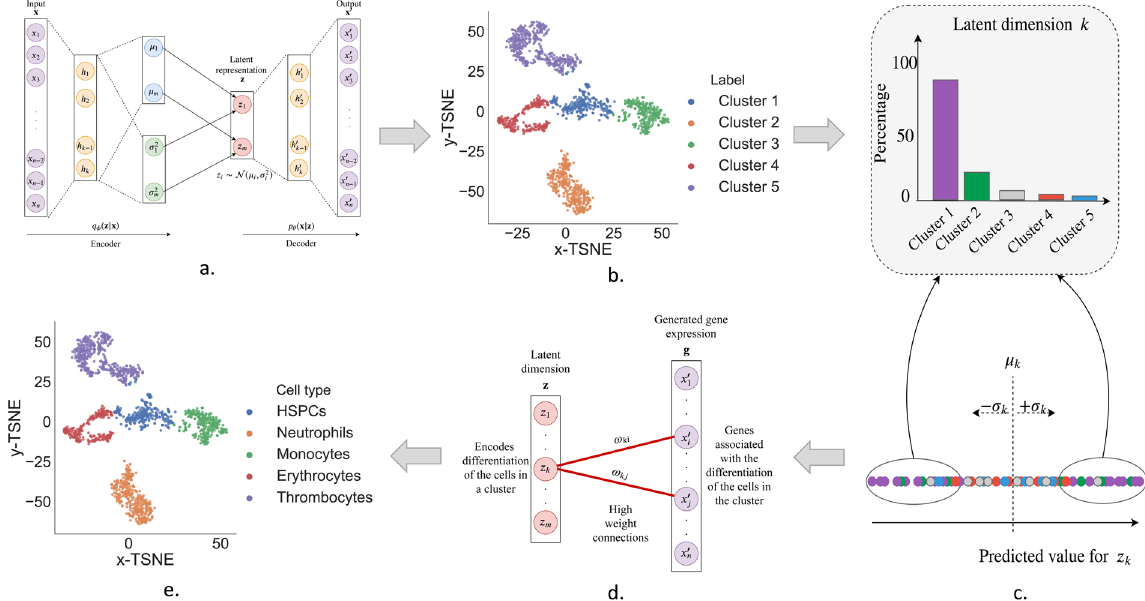
Figure 1. Pipeline for identifying the cell types in a dataset using DiffVAE. Illustration on the zebrafish dataset. ( a ) Train DiffVAE to map the gene expression measurements for each cell to a m -dimensional latent representation z . ( b ) Apply T-SNE on the latent representation z and clustering to find the different cell clusters in the dataset. ( c ) Identify which latent dimensions in z encode the differentiation of the cells in each cluster. ( d ) Find the high weights genes for the relevant latent dimensions. ( e ) Map the clusters to cell types based on the high weight genes for each